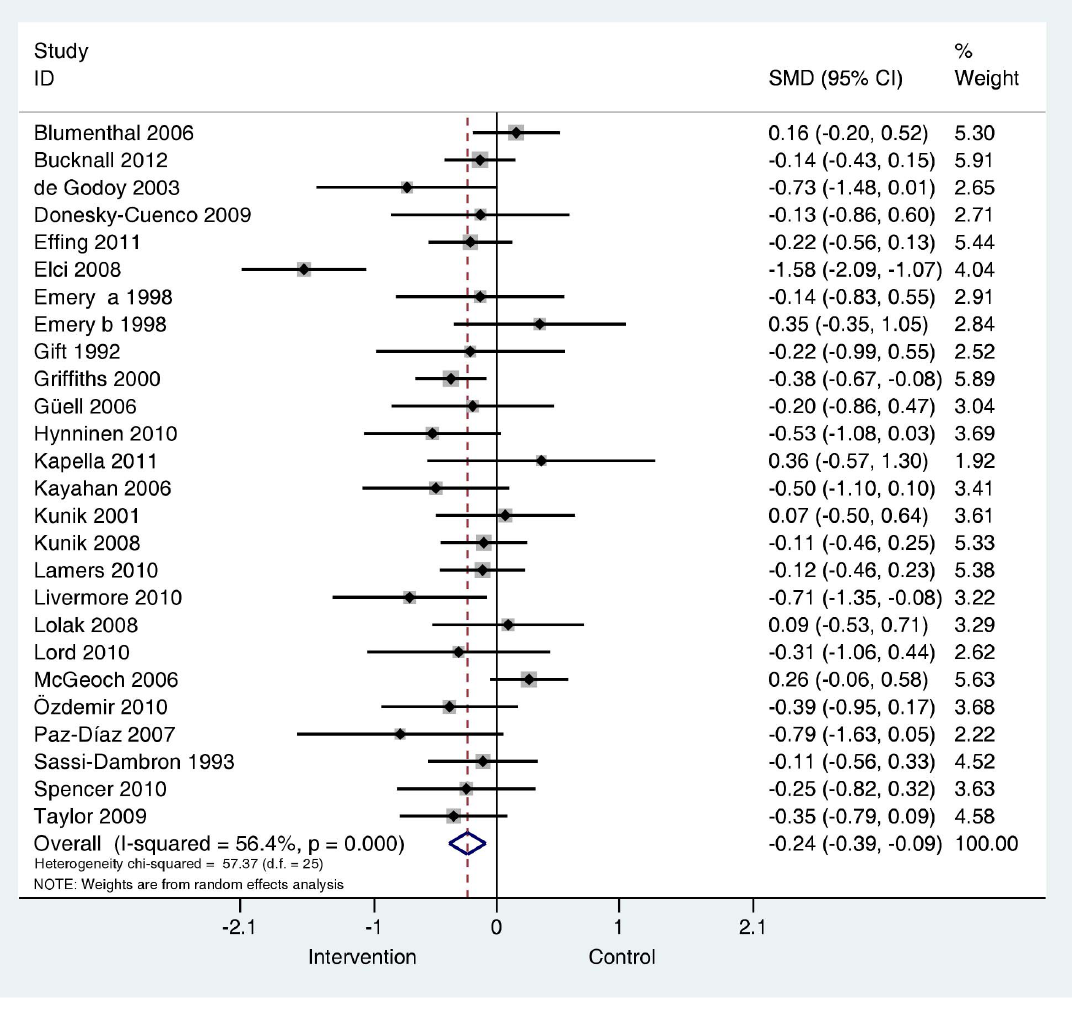
Figure 3. Effects of complex interventions on self-reported anxiety symptoms at post-treatment. Note: Meta-analysis of individual trial and pooled effects. Random effects model used. 95% CI=95% confidence intervals; SMD=standardised mean difference.